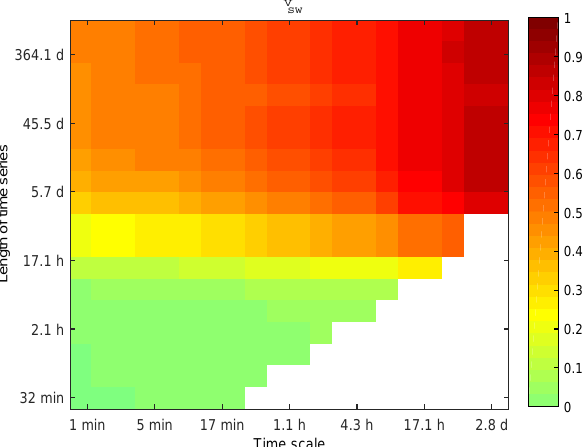
Figure 8. Correlation between Pc3 ind and V sw (colour scale) over different timescales (horizontal axis) and data set lengths (vertical